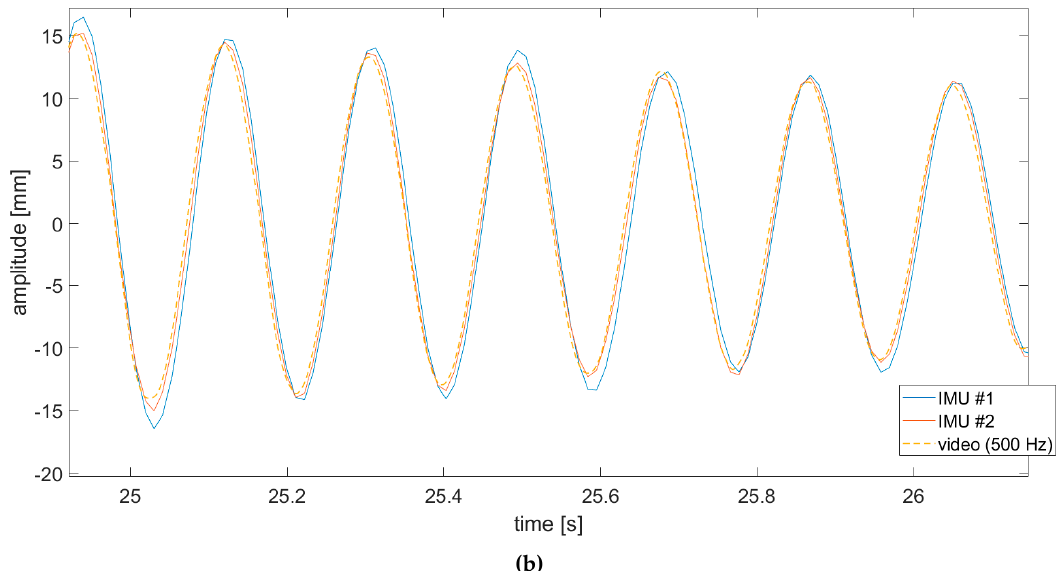
Figure 7. ( a ) Comparison of displacement time histories (video vs. IMUs #1 and #2 acquisitions). ( b ) Zoom on a one-second-long tract.